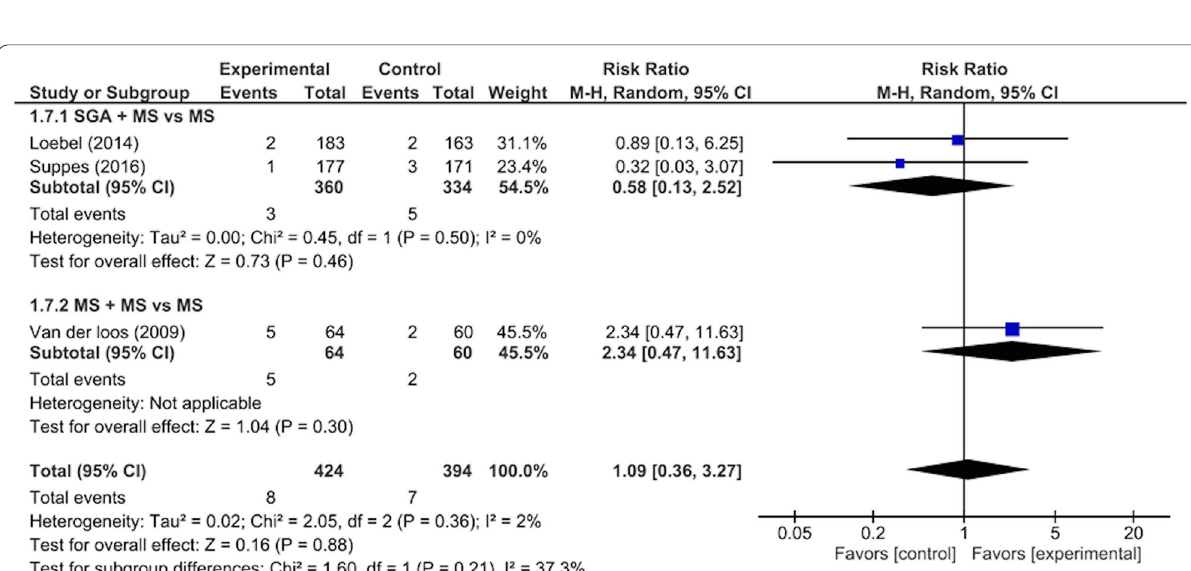
Fig. 9 Forest plot of post-intervention treatment effect sizes for rate of manic switching. Subgroup analysis of types of combination therapy. CI, confidence interval; SD, standard deviation; MS, mood stabilizers, including lamotrigine, lithium, and valproate; SGA, second-generation